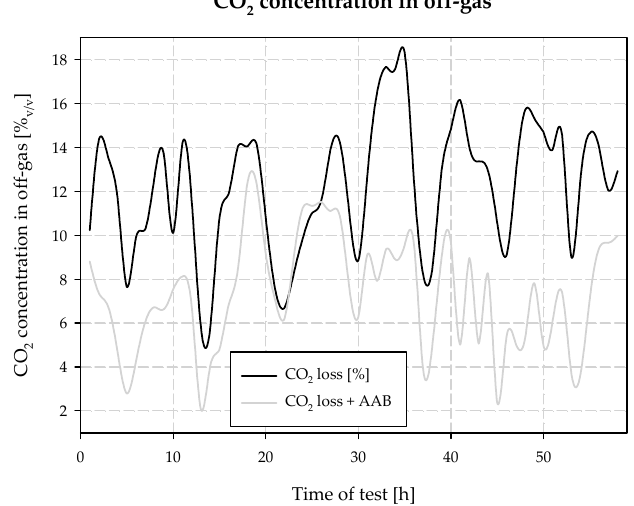
Figure 18. CO 2 losses during the test of dosing the AAB to barrel 8. For CO 2 and NH 3 concentration control, an Ultramat 23 gas analyzer by SIEMENS K3-374 was installed in the industrial installation at the outlet of the gases from the column. The automation of sampling, drying, and the use of IR analysis made it possible to measure the concentration of CO 2 and NH 3 in the exhaust